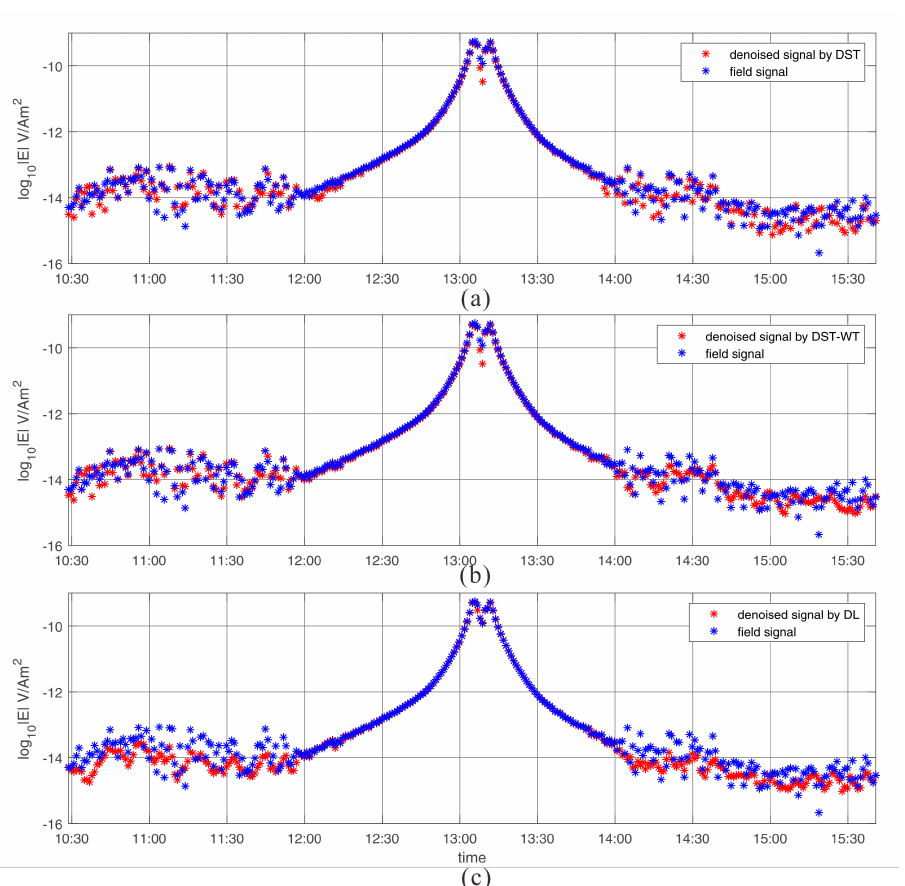
Figure 12. The MVT plot at frequency 0.5 Hz for field data. ( a ) is the denoising result under DST dictionary, ( b ) is the denoising outcome under DST-wavelet merged dictionary and ( c ) is the denoising result under learned